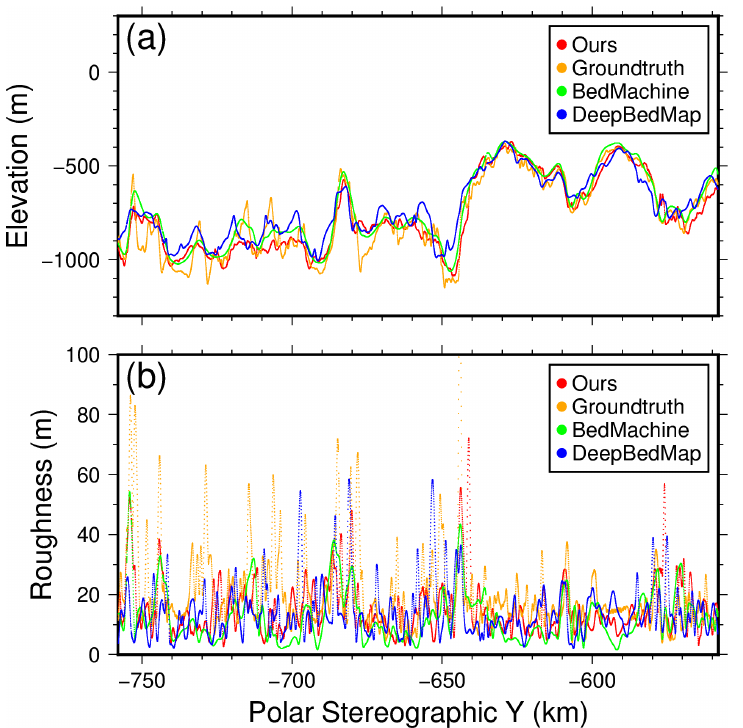
Figure 14. Comparison bed elevation ( a ) and bed roughness ( b ) of each grid product over a transect in Marie Byrd Land (see Figure 11i, orange